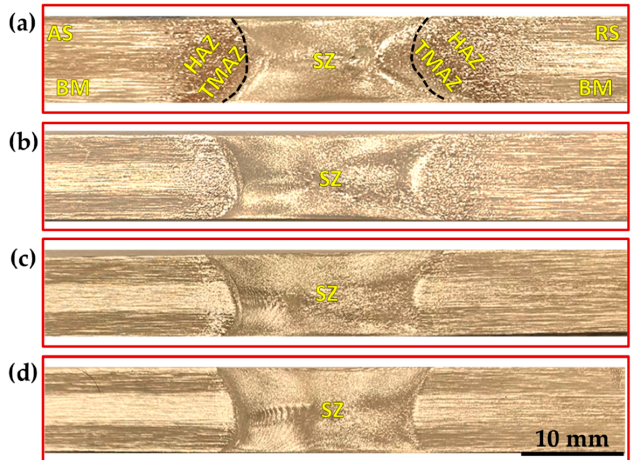
Figure 15. Macrostructure of the AA1050 BT-FSPed specimens at a constant rotation rate of 600 rpm using Cy pin (where BM: base material, SZ: stir zone, HAZ: heat-affected zone, and TMAZ: thermo- mechanically affected zone) and different travel speeds of ( a ) 50 mm/min; ( b ) 100 mm/min; ( c ) 200 mm/min, and ( d ) 300 mm/min.